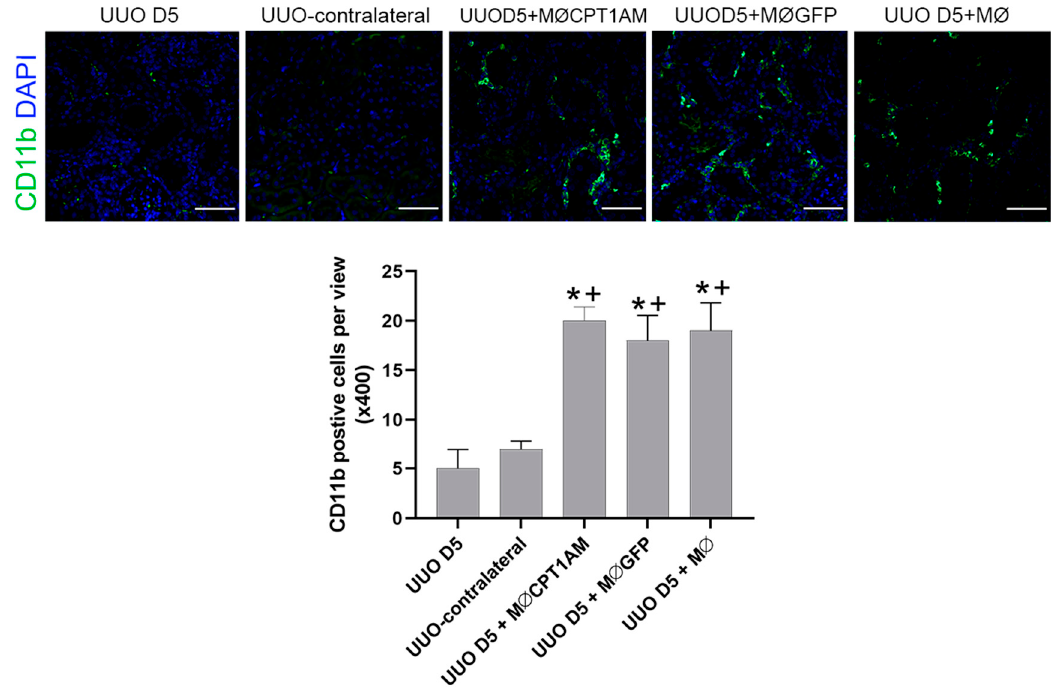
Figure 6. CD11b positive cells in Kidney tissue of UUO-induced fibrosis mice with or without macrophage cell therapy. Immunofluorescence of kidney section with the antibody against CD11b (green); nuclei were stained with DAPI (blue) in UUO operated mice that received, at day 3 of UUO, an intravenous injection of macrophages transduced with either CPT1a or GFP, and macrophage without transduction. Kidneys were harvested 48 h after cell therapy at day 5 following UUO. Vehicle group received an intravenous injection of PBS (UUO D5) and contralateral kidney of UUO mice served as control. Objective magnification ×400, scale bar 50 µm. * p < 0.05 vs. UUO day 5. + p < 0.05 vs. UUO-contralateral.